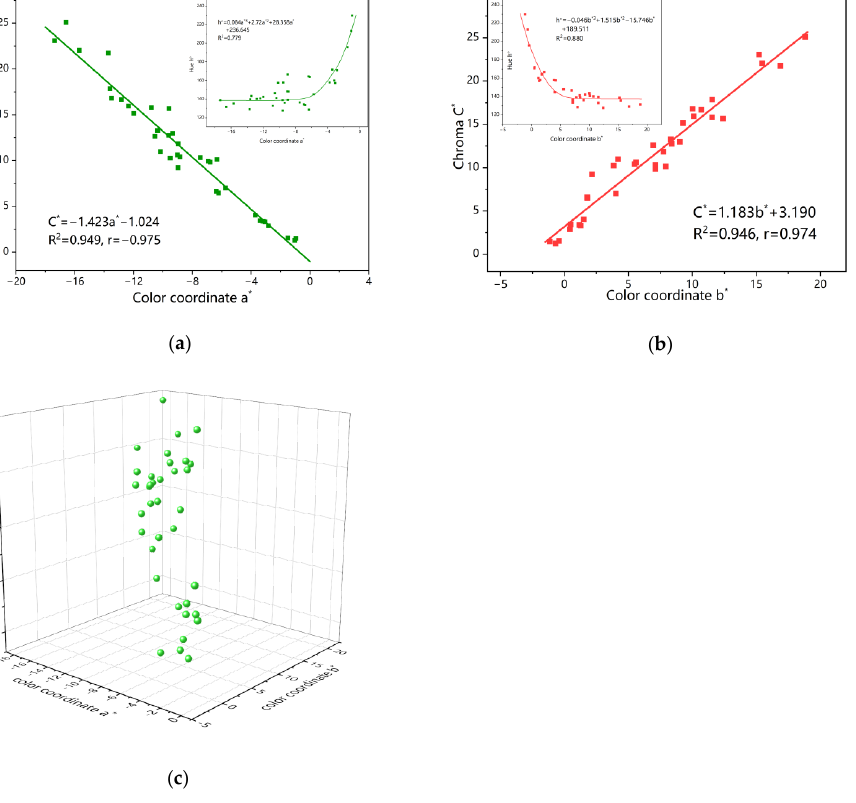
Figure 2. ( a ) The relation between the a* and the chroma C*, hue angle h ◦ ; ( b ) the relation between the b* and the chroma C*, hue angle h ◦ ; ( c ) color parameters of 36 serpentine jade samples plotted in the CIE 1976 L*a*b*uniform color